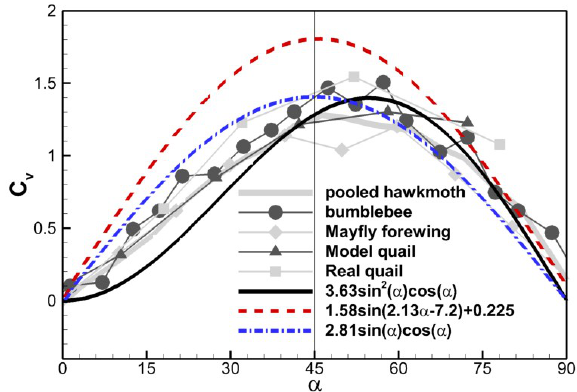
Figure 9. Comparison of scaling relations with experimental data digitalized from Figure 8b, Usherwood and Ellington [7].